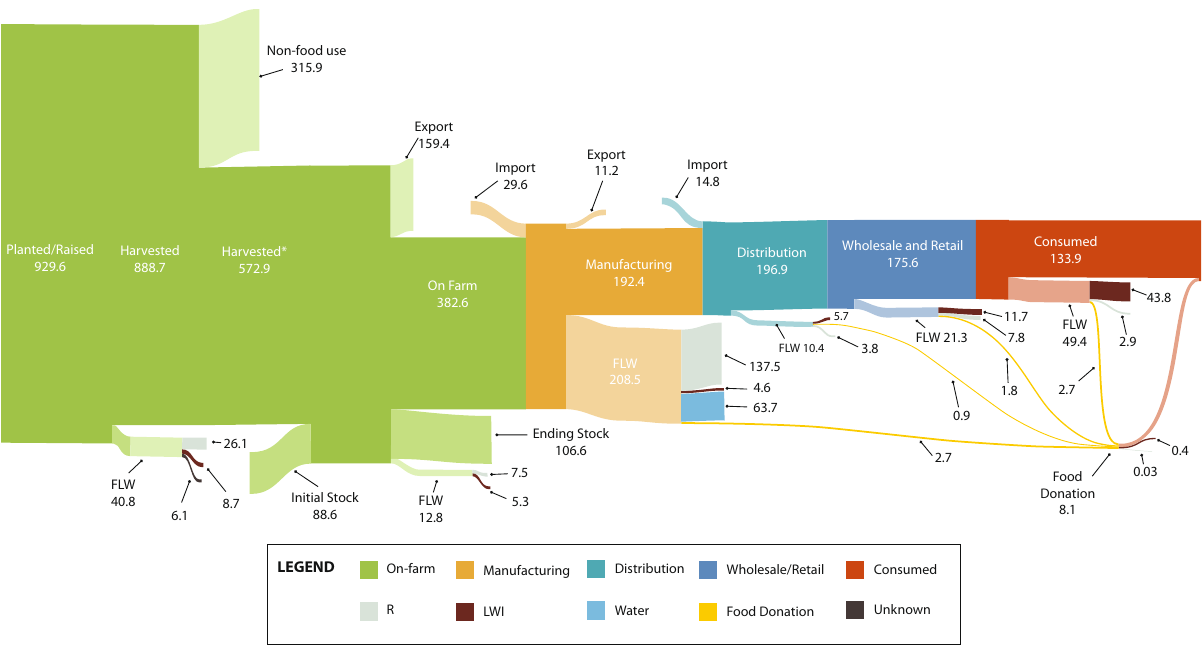
Fig. 1 Sankey diagram of the mass fl ows of the 2016 U.S. FSC (in MMT). Mass fl ow of food across the 2016 U.S. FSC in MMT. The different stages are labeled and in different colors, and lighter shades represent inlet and outlet fl ows directly from the main mass fl ow. On-farm activities, in light green, consist of Planted/Raised (e.g., crops planted, or animals raised), Harvested (total agricultural materials harvested), Harvested* (where the asterisk represents that it is food intended for human consumption), and fi nally On-farm (representing the mass fl ow out of the on-farm stage). On-farm also includes several inlet and outlet fl ows (all in a lighter shade of green): non-food use (agricultural materials harvested speci fi cally for non-human food uses — e.g., biofuel production, animal feed), exports, initial and ending stock, and two FLW streams (unharvested and unsold food). All other stages only have one substage within them and only Manufacturing (human food manufacturing; in orange) and Distribution (in teal) have inlet and outlet fl ows beyond FLW (imports and exports and imports only, respectively). Wholesale and Retail (W&R; dark blue) and Consumed (food consumed at the Consumption stage; red) only have FLW fl ows leaving the main FSC. All FLW fl ows have several potential outlets: FLW managed through animal feed, composting, AD, land application, biochemical processing (R, gray green); FLW disposed of through land fi ll, wastewater treatment, and incineration (LWI, dark red), unharvested animal product waste with unknown disposal (unknown, dark gray), mass removed via evaporation (or other similar processes) in manufacturing (water, light blue), and food donation